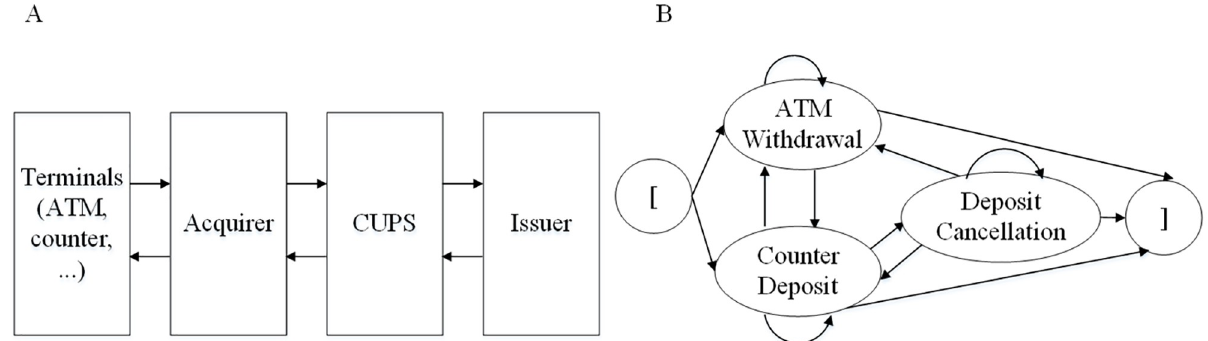
Fig 9. Process and ESG of interbank transactions. A:Process. B:ESG.